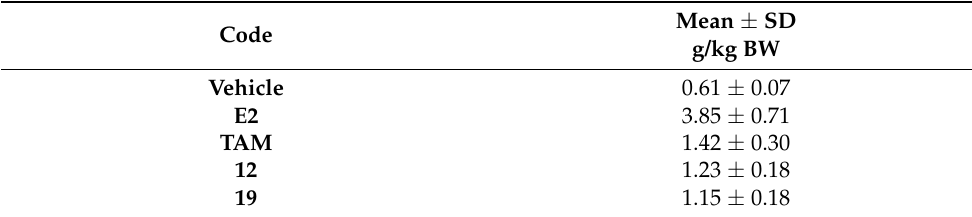
Table 7. Relative uterus wet weight of ovariectomized rats